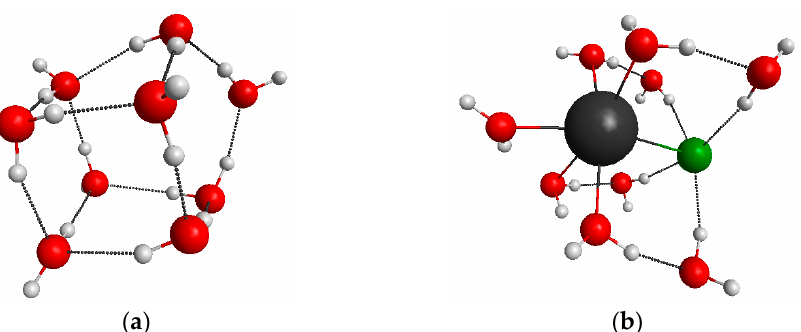
Figure 13. Spatial arrangement of atoms in the clusters of water ( a ), and sodium chloride solution with maximum concentration ( b ).